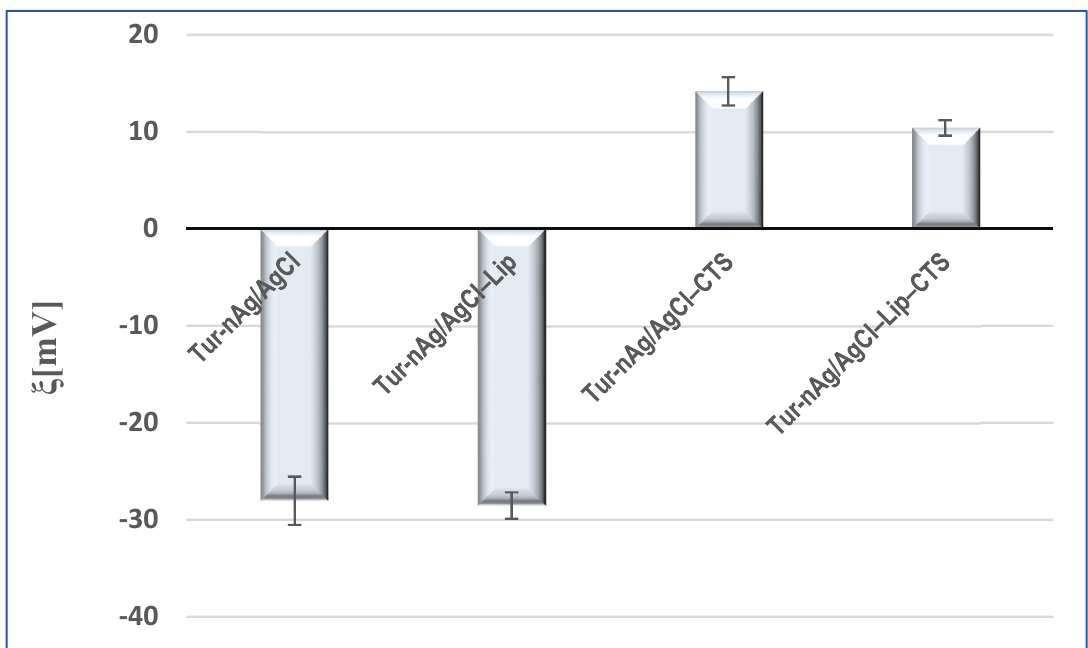
Figure 7. Zeta potential values of developed silver-based particles.